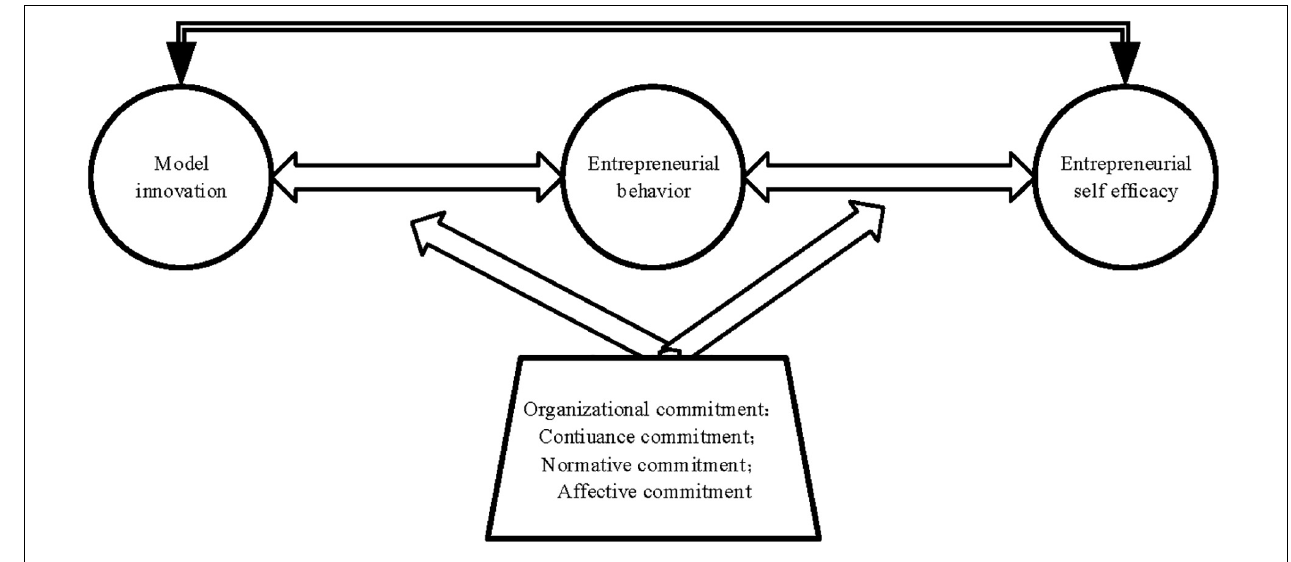
FIGURE 1 | Theoretical research model. TABLE 2 |